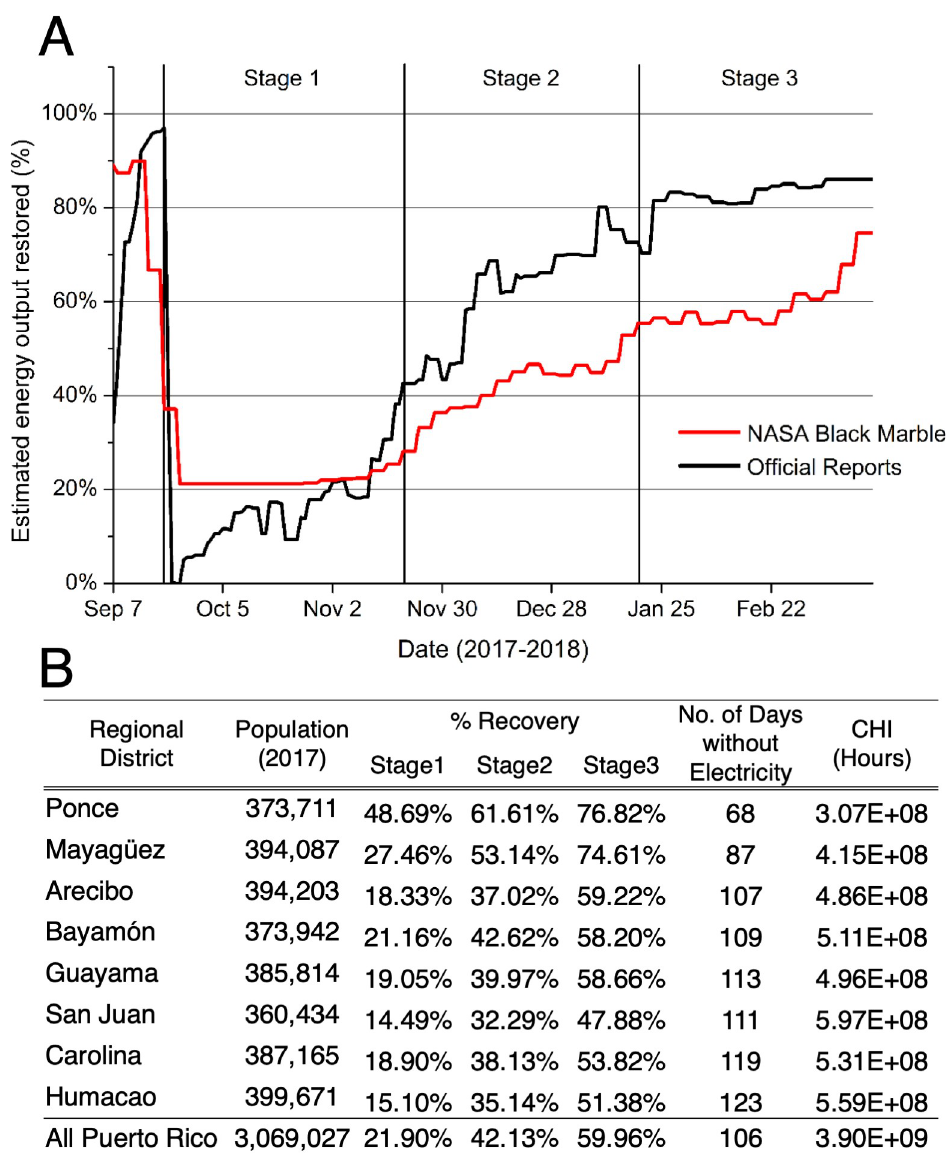
Fig 2. Satellite-derived nighttime lights products agree with official records of total electricity generation following Hurricane Maria in Puerto Rico (R = 0.839, SE = 0.1601, P < 0.0001, n = 195 days). (A) Comparisons between total shares of peak load restored and lighting patterns Results show distinct variations between three disaster stages. (B) District-specific outage metrics include ‘% Recovery’ (scaled units of radiance relative to pre-event values), number of days without electricity (NDWE), and customer hours of interruption (CHI) (see Supplementary Information for details).